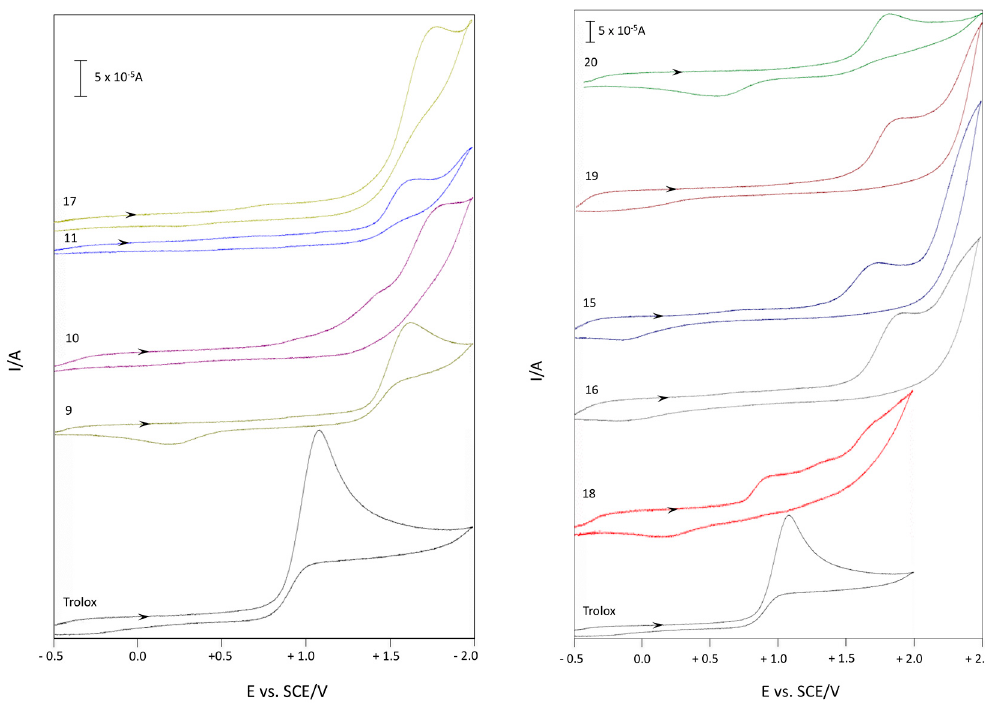
Figure 5. Voltammetric curves of compounds 9 – 11 and 15 – 20 in acetonitrile (c = 2 × 10 − 3 M) in acetonitrile (MeCN-0.1 M Et 4 NBF 4 ). Starting potential: − 0.5 V; reversal potential: +1.5 V (GC working electrode, ν = 0.2 V·s − 1 , SCE reference electrode, 25 °C, N 2 ).